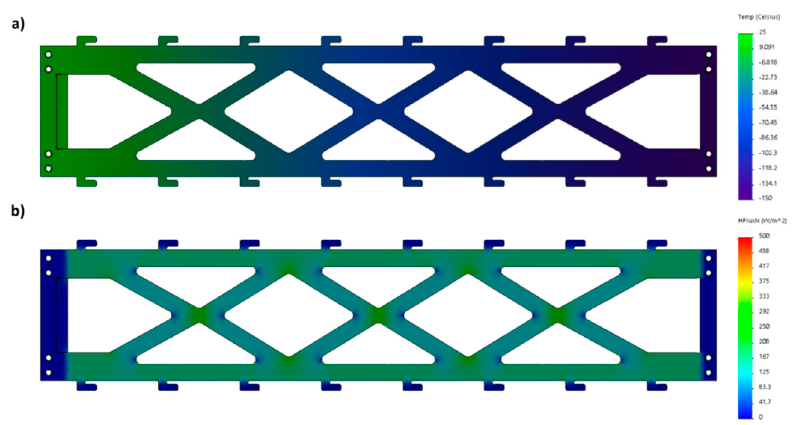
Figure 9. Thermal analysis of the outer epoxy support when the large clutch is at − 150 °C. ( a ) A temperature map and ( b ) the heat flux. The power transferred in this simulation was about 0.02 W. Since the model is the same, the same mesh was used to simulate it with a different temperature in the extremity; the result is as plotted below. Again, the top of Figure 10 shows the temperature gradient on the epoxy, and on the bottom the heat flux. The power transferred was 0.015 W.